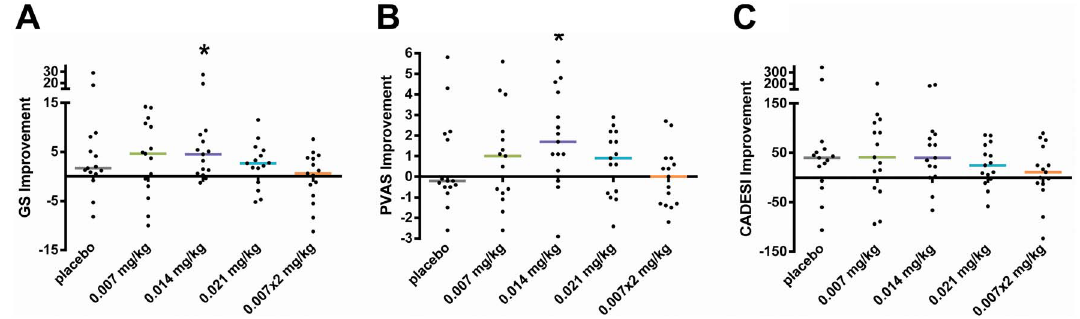
Figure 4. Effect of placebo and LD-aminopterin on canine AD disease measures. Subjects ( N =75) with AD were randomized equally to receive placebo, or LD-aminopterin once-weekly (0.007, 0.014 or 0.021 mg/kg) or twice-weekly (0.007 6 2 mg/kg). Improvement in baseline disease measures were determined for (A) GS, (B) PVAS and (C) CADESI (see Materials and Methods). GS and PVAS improved significantly in the 0.014 mg/kg cohort. * P , 0.05. Horizontal bars are medians. Abbreviations: GS, Global Score; PVAS, Pruritus Visual Analogue Scale; CADESI, Canine Atopic Dermatitis Extent and Severity Index 03.